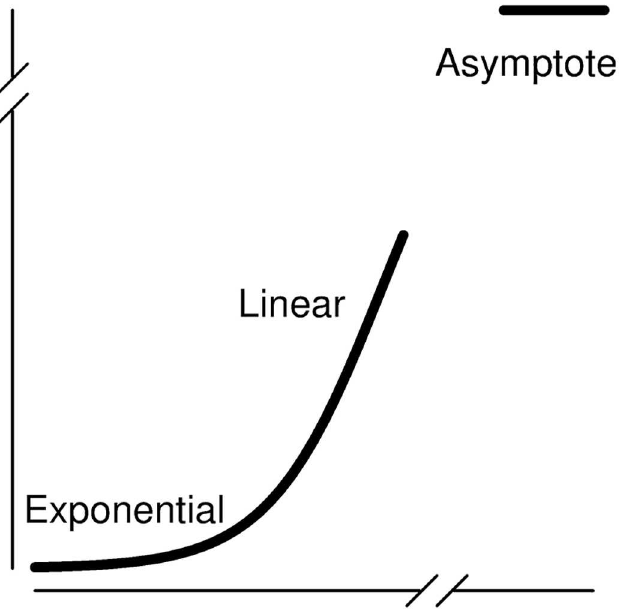
Fig 2. Salient featuresof a multistage clonal expansion model hazard. Multistageclonalexpansion models have exponentialand linear phases that may be observedon the time scale of a human lifespan. Depending on the numberof stages in the model, the asymptote may or may not occur within a human